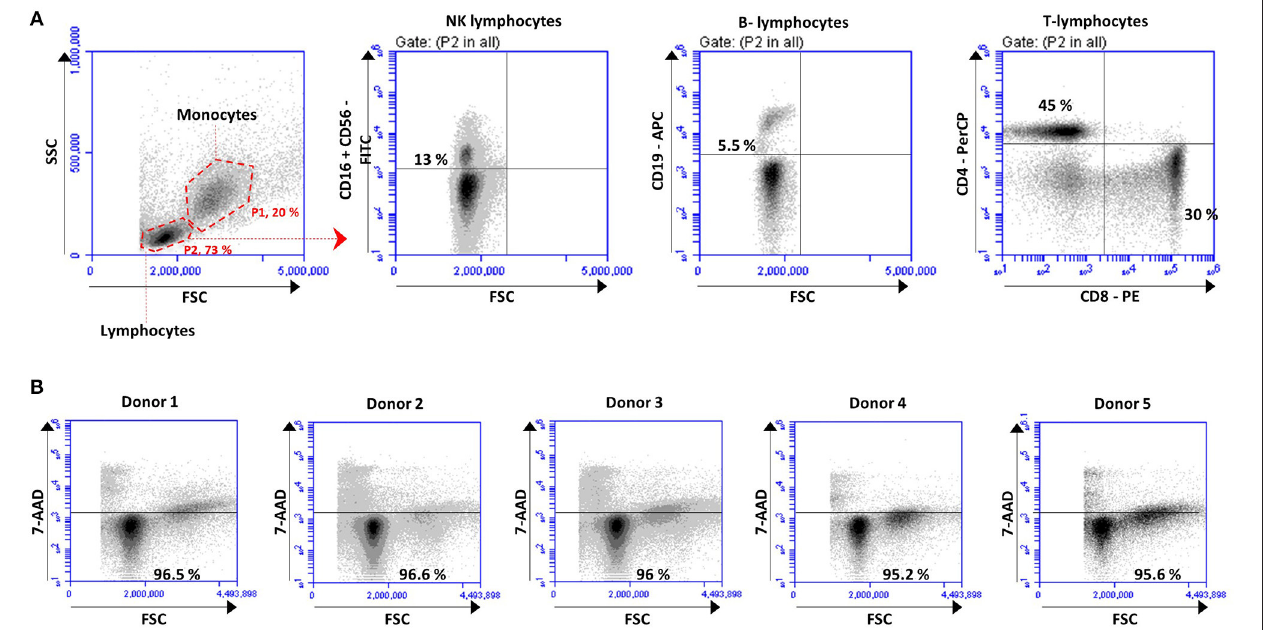
FIGURE 2 | PBMCs isolated from the buffy of 5 healthy donors were analyzed before and after co-culture for 48h to (A) quantified lymphocyte subsets and (B) cell viability. (A) Gating strategy used to identified monocytes (P1, 20%), lymphocytes (P2, 73%) and to quantified the different lymphocytes subsets: NK lymphocytes (CD16 + CD56 + ), B-lymphocytes (CD19 + ), CD4 T-lymphocytes (CD4 + ) and CD8 T-lymphocytes (CD8 + ). Density plots correspond to one representative donor. The percentage of positive cells in each subset is expressed based on the gate of lymphocytes (P2). (B) Cell viability analyses performed after 48h based on the percentage of cells of each donor not labeled with